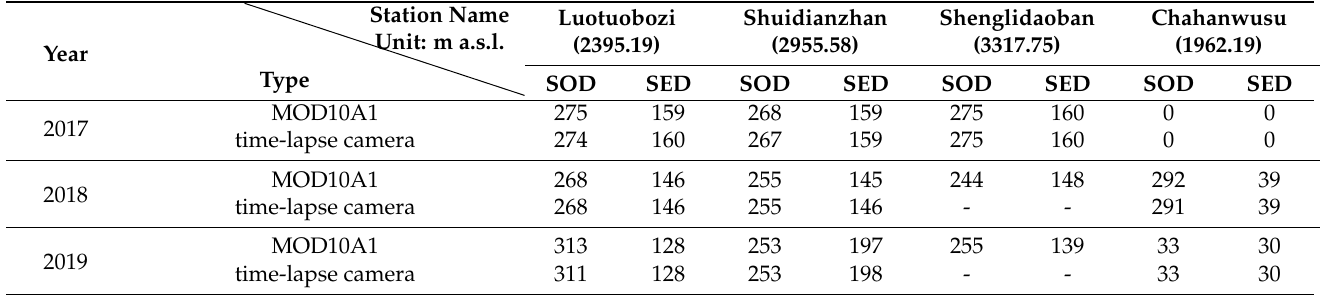
Table 3. Comparison between camera data and MOD10A1 snow cover phenological parameters. (Unit: